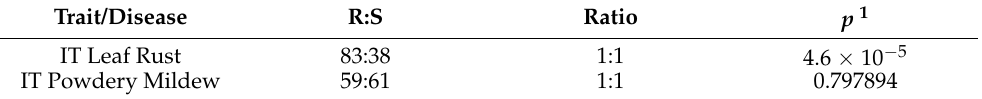
Table 2. The observed segregation ratio among resistant (R) and susceptible (S) lines.